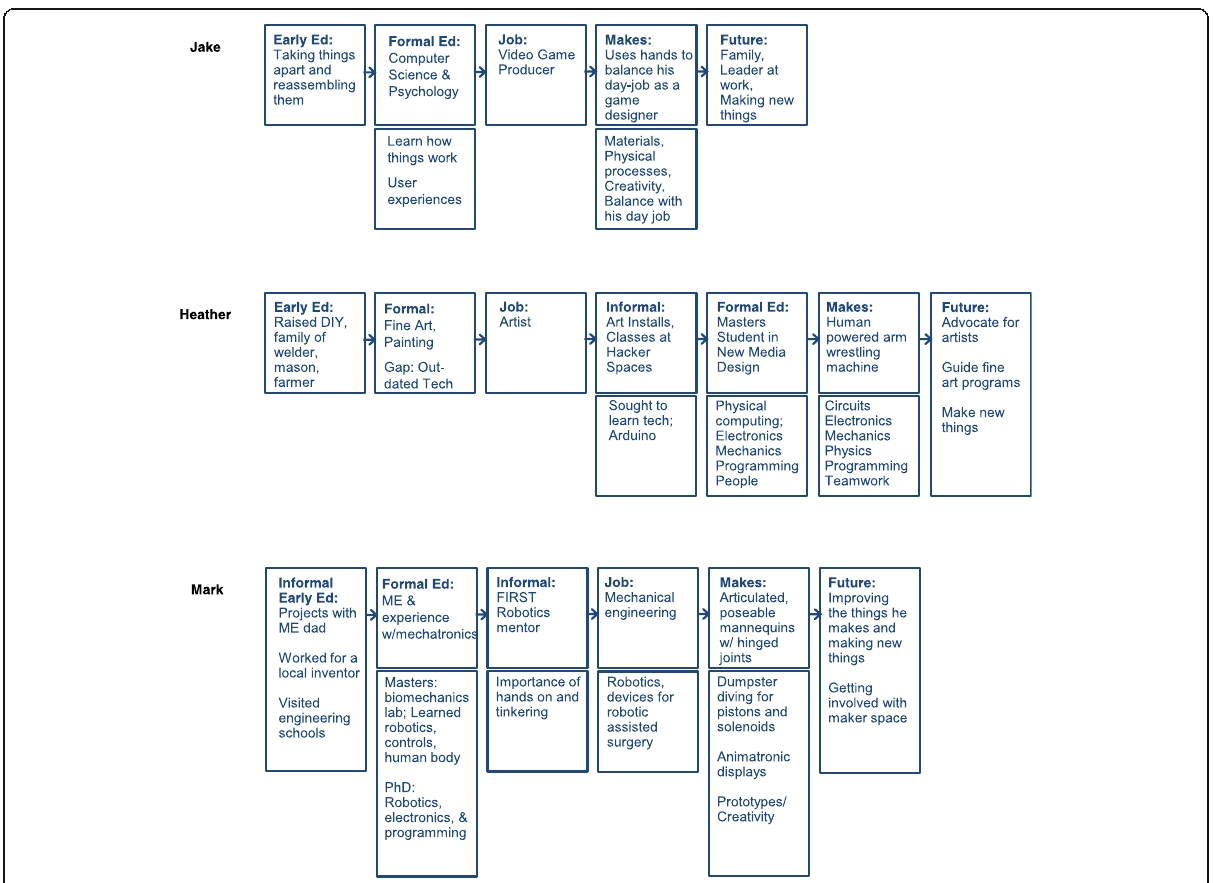
Fig. 6 Parallel pathways for the Makers of large-scale interactive